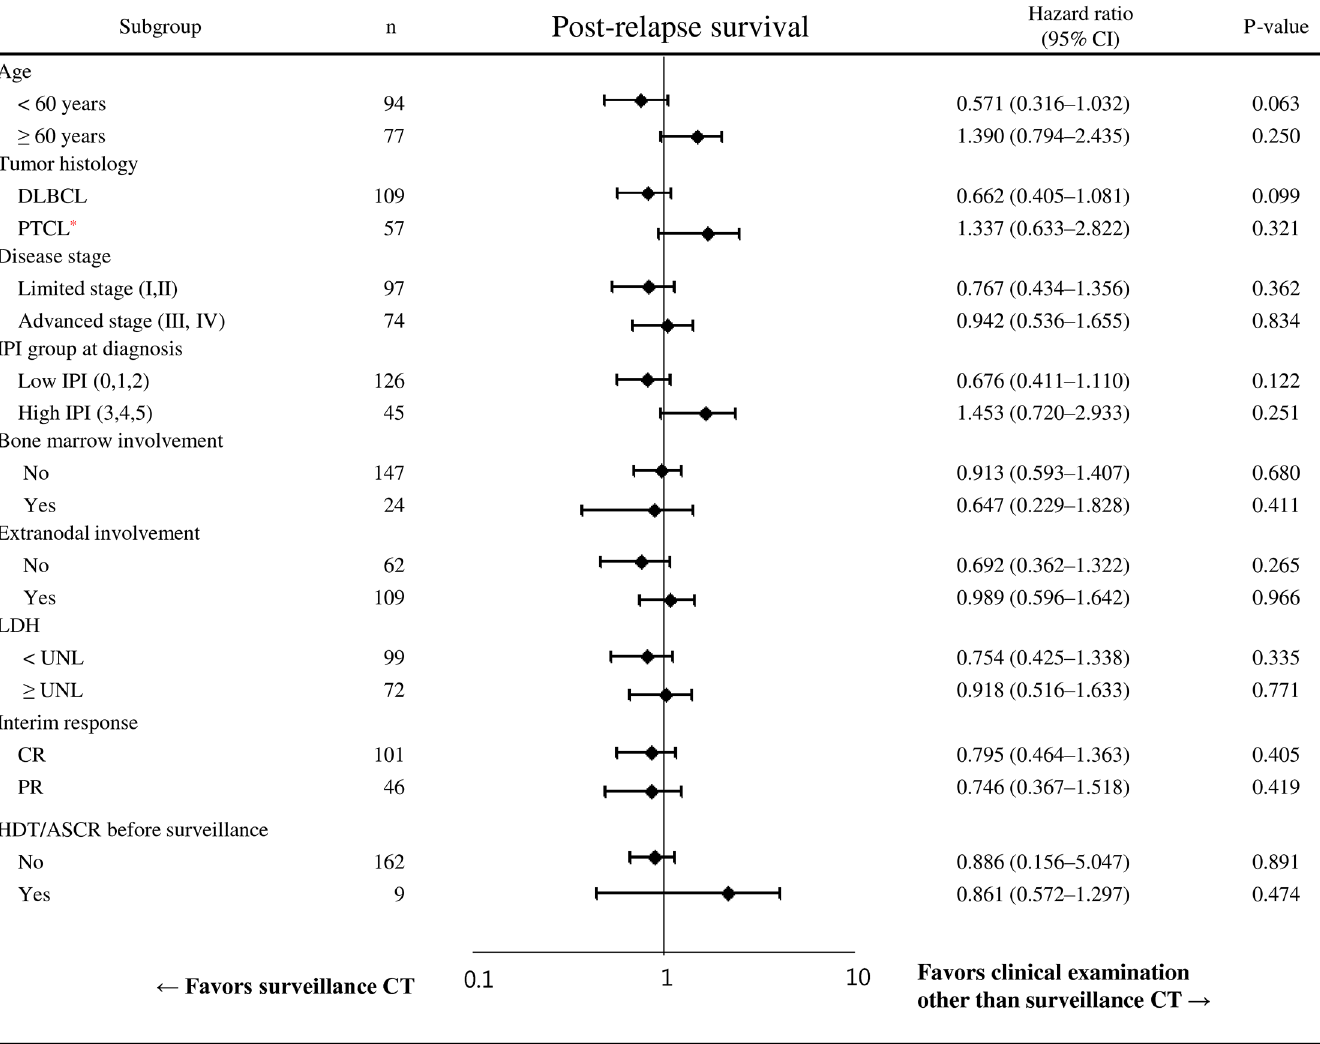
Fig 3. Subgroup analysis of post-relapse survival according to relapse detection method in relapsed aNHL patients after CR1. (cid:3) PTCL includes peripheral T-cell lymphoma not otherwise specified, angioimmunoblastic T-cell lymphoma, anaplastic large cell lymphoma, and NK/T cell lymphoma. Abbreviations: CR1, complete remission after frontline chemotherapy; CI, confidence interval; DLBCL, diffuse large B-cell lymphoma; PTCL, peripheral T-cell lymphoma; LDH, lactate dehydrogenase; IPI, International Prognostic Index; UNL, upper normal limit; CR, complete remission; PR, partial remission; HDT/ASCR, high-dose therapy with autologous stem cell